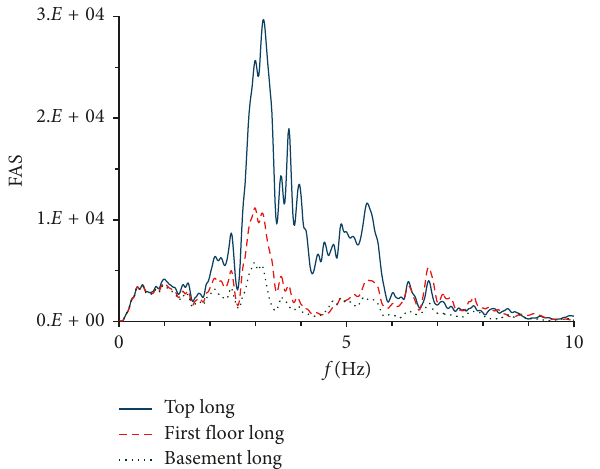
Figure 21: Fourier spectra of the time histories in Figure 20, obtained in the longitudinal direction at the basement, at the first floor just above the isolation system, and at the top of the building,